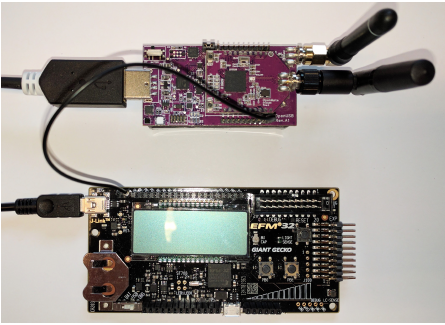
Figure 4. Setup used to measure state durations with a connection from the PB9 pin on the Gecko board (bottom) and to the PD2 pin on the OpenUSB